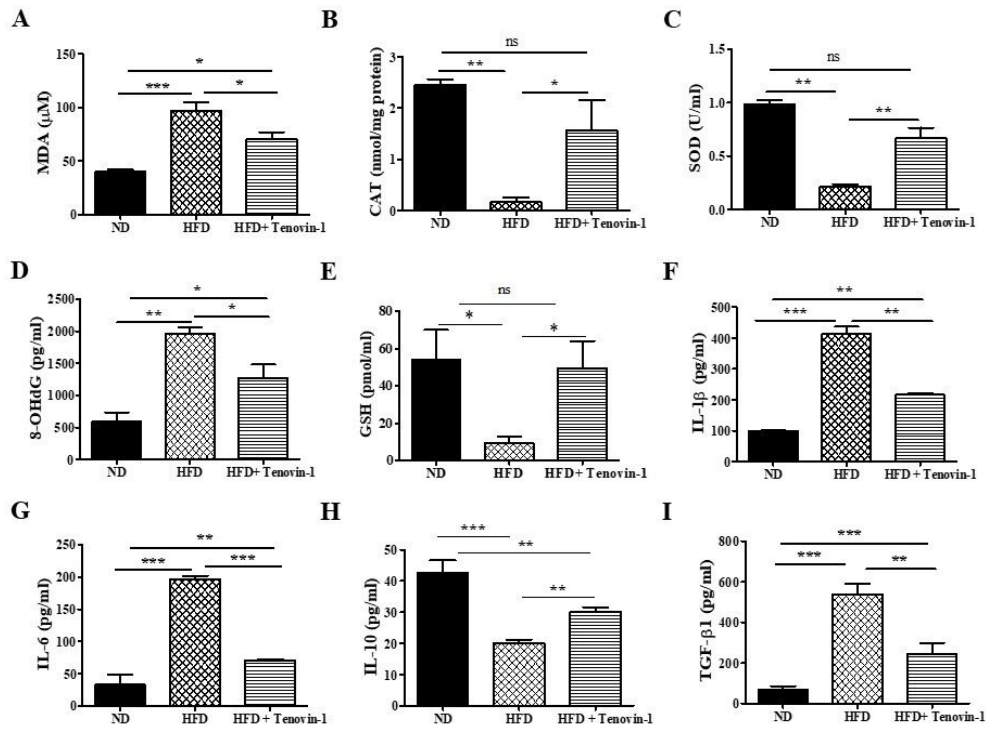
Figure 4. Effect of Tenovin ‐ 1 on the antioxidant enzyme activity, proinflammatory cytokines, and an anti-inflammatory cytokine in HFD-induced diabetic rats. Changes in oxidative biomarkers, such as in ( A ) levels of lipid peroxidation biomarker (malondialdehyde (MDA)) ( B ) and activities of catalase (CAT) and ( C ) superoxide dismutase (SOD), were assessed in the kidneys of HFD-induced rats. The level of an oxidative DNA damage marker, ( D ) 8 ‐ hydroxy ‐ 2 ′‐ deoxyguanosine (8 ‐ OhDG), was measured in the urine of the HFD ‐ induced rats. The levels of measured oxidative biomarkers were restored after Tenovin ‐ 1 treatment. ( E ) Endogenous glutathione (GSH) was measured in the kidneys of HFD ‐ induced rats. ( F – I ) The levels of proinflammatory cytokines (IL-1 β , IL-6, and TGF- β 1) were significantly decreased, and the level of anti-inflammatory cytokine (IL-10) was significantly augmented after treatment of HFD ‐ fed rats with Tenovin-1. The data are the mean ± SD of duplicate experiments (6 animals/group). Statistical analysis was performed using one-way ANOVA followed by Tukey’s HSD post hoc test for multiple comparisons (*** p < 0.001, ** p < 0.01, and * p < 0.05). ʺ ns ʺ (two groups are non ‐ significant with each other). ND, normal diet; HFD, high-fat diet.